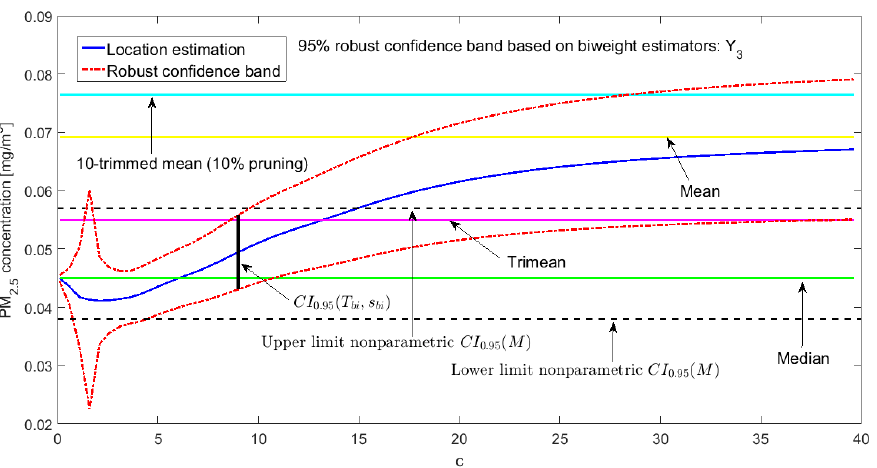
Figure 16. 95% robust confidence band based on the biweight estimators: Y 3 .